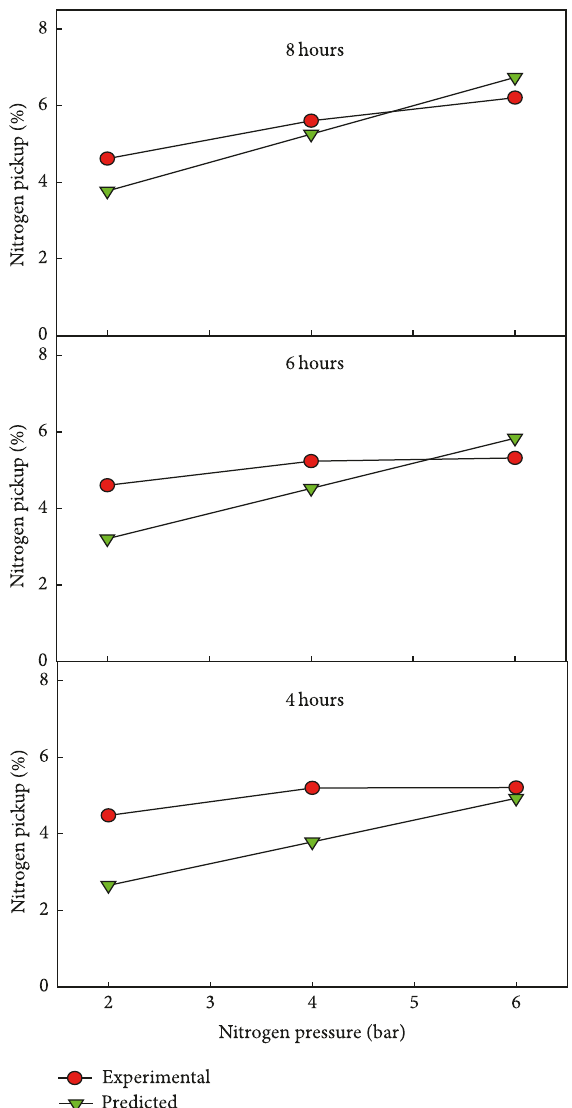
Figure 7: Variation between the predicted and published nitrogen pickup of medium carbon (2.2% C) ferromanganese at 4, 6, and 8 hours with nitrogen pressure at 950 ∘ C